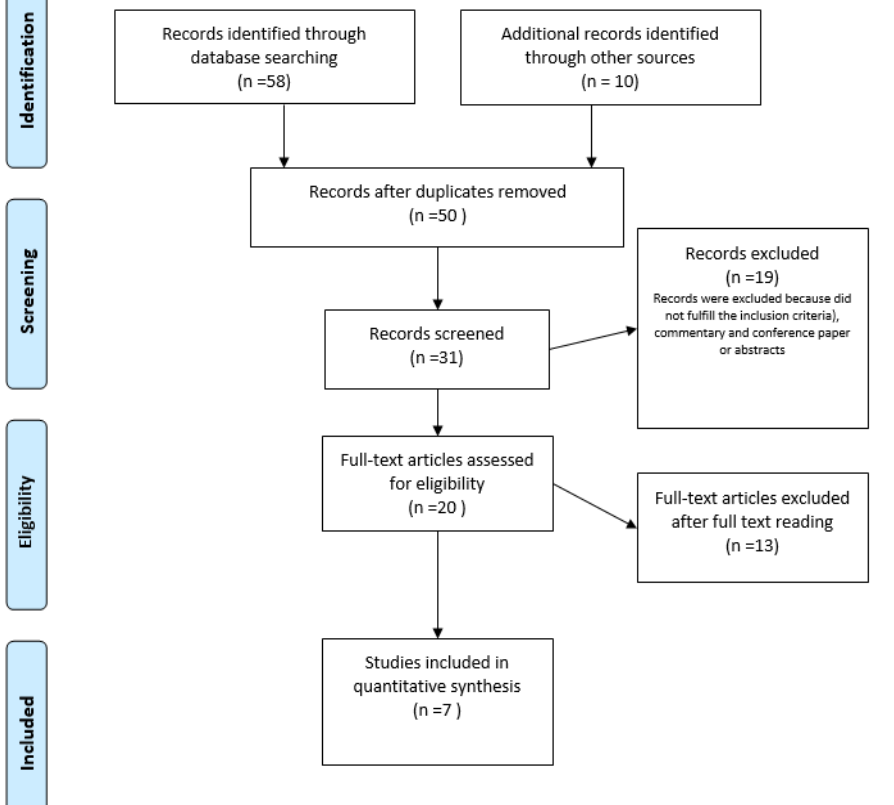
Figure 2. PRISMA flow diagram of the study selection